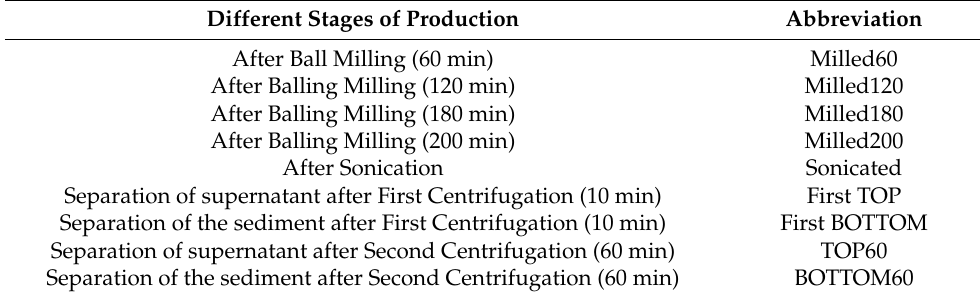
Table 1. Samples obtained according to different preparation steps and abbreviations adopted in the text. Different Stages of Production Abbreviation After Ball Milling (60 min) Milled60 After Balling Milling (120 min) Milled120 After Balling Milling (180 min) Milled180 After Balling Milling (200 min) Milled200 After Sonication Sonicated Separation of supernatant after First Centrifugation (10 min) First TOP Separation of the sediment after First Centrifugation (10 min) First BOTTOM Separation of supernatant after Second Centrifugation (60 min) TOP60 Separation of the sediment after Second Centrifugation (60 min)